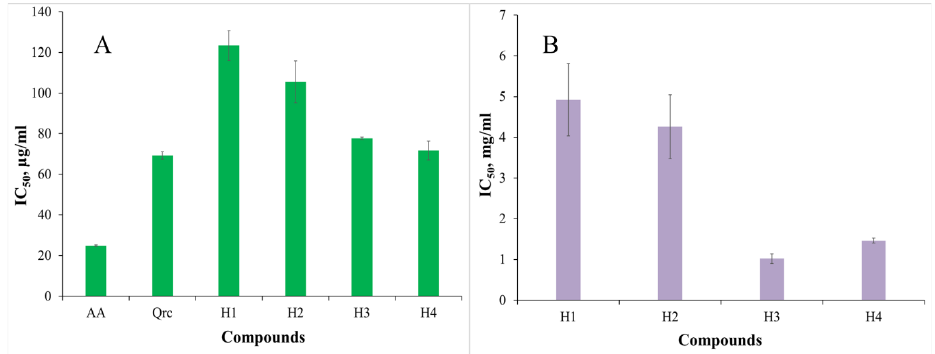
Figure 4. Ability of furan derivatives to scavenge hydrogen peroxide (HPSA) ( A ) and form chelate complexes with Fe(II) ions (MChA) ( B ). Standards employed in this study were ascorbic acid (AA) and quercetin (Qrc). IC 50 values were used to assess the HPSA and MChA outcomes.